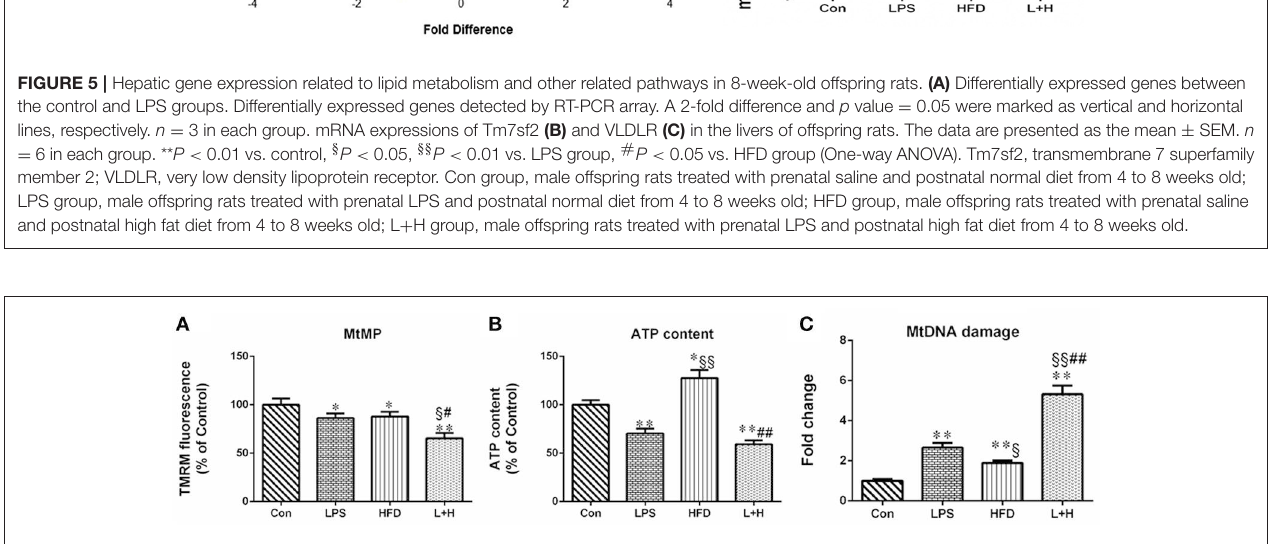
FIGURE 6 | Hepatic mitochondrial membrane potential, (A) , ATP content (B) and mitochondrial DNA (MtDNA) damage (C) in 8-week-old offspring rats. The result about mitochondrial membrane potential and ATP content is expressed as % control, however, MtDNA damage is represented as “fold increase” over the controls in mitochondrial common deletion. The data are presented as the mean ± SEM. n = 6 in each group. * P < 0.05, ** P < 0.01 vs. control, § P < 0.05, §§ P < 0.01 vs. LPS group, # P < 0.05, ## P < 0.01 vs. HFD group (One-way ANOVA). Con group, male offspring rats treated with prenatal saline and postnatal normal diet from 4 to 8 weeks old; LPS group, male offspring rats treated with prenatal LPS and postnatal normal diet from 4 to 8 weeks old; HFD group, male offspring rats treated with prenatal saline and postnatal high fat diet from 4 to 8 weeks old; L + H group, male offspring rats treated with prenatal LPS and postnatal high fat diet from 4 to 8 weeks